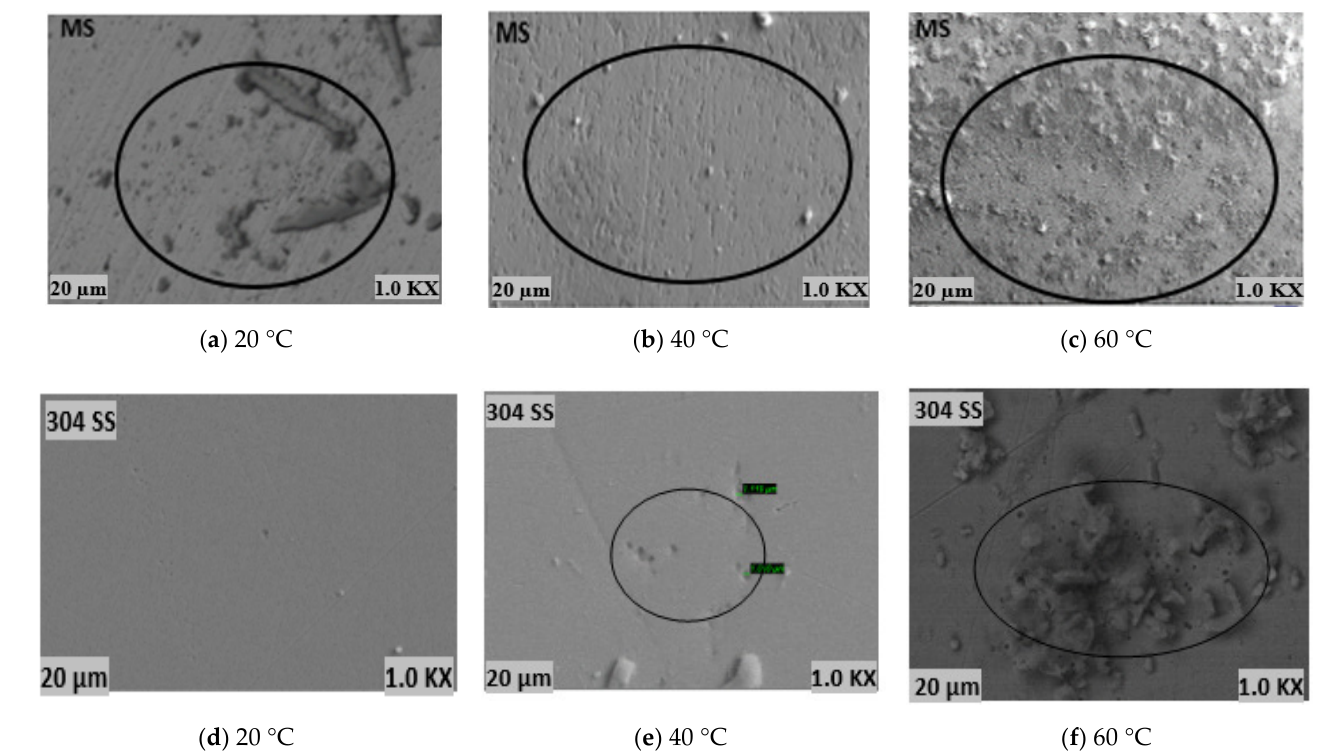
Figure 8. SEM micrographs of uninhibited ( a – c ) MS and ( d – f ) 304 SS sample surfaces obtained after exposure to 3.5% NaCl solution at 20 °C, 40 °C, and 60 °C.